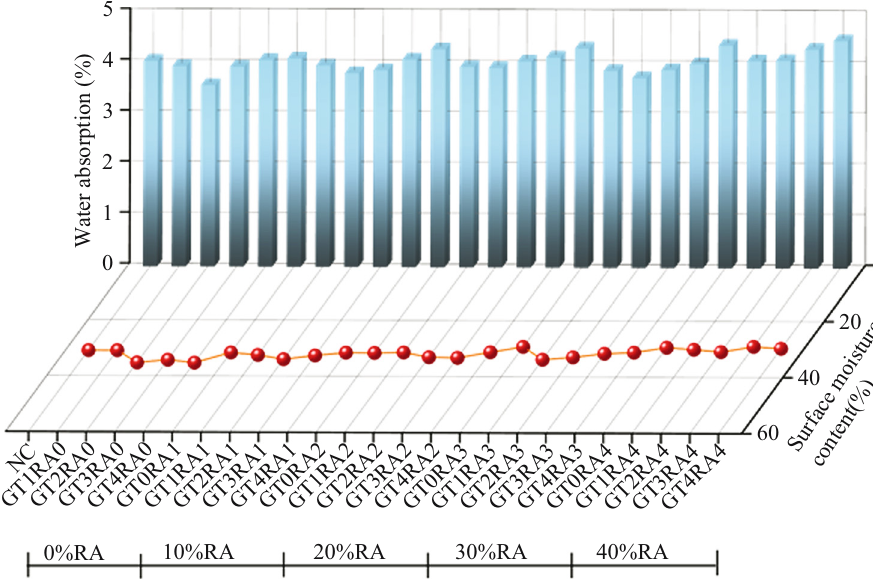
Figure 5: Surface moisture content and water absorption of GTRAC ( GT1RA1 is the graphite tailing – RA concrete in which 10% GT + 10% RA )